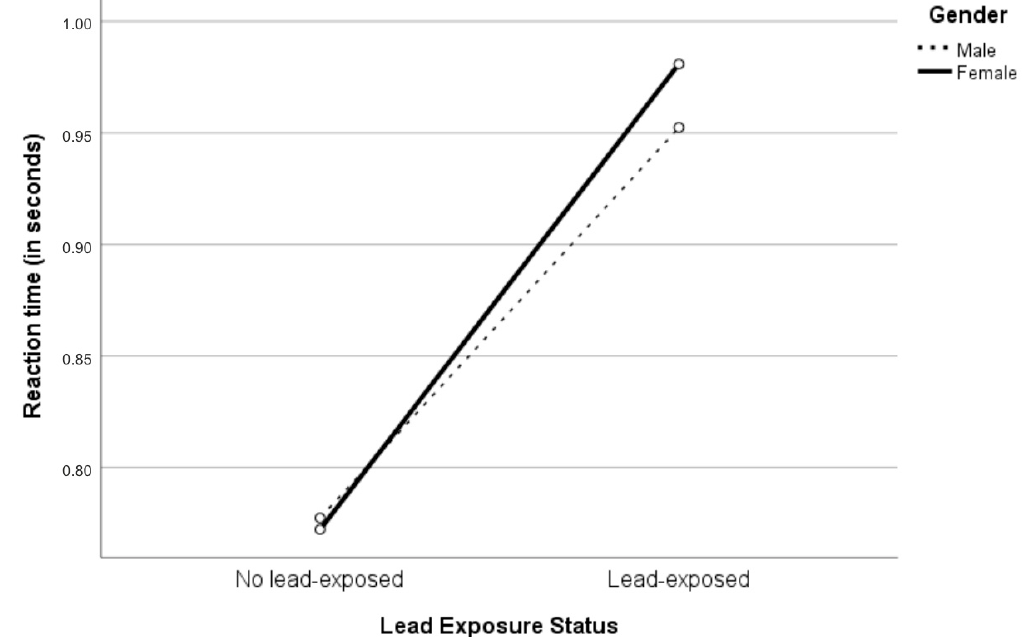
Figure 2. Interaction between gender and lead exposure status to the reaction time.